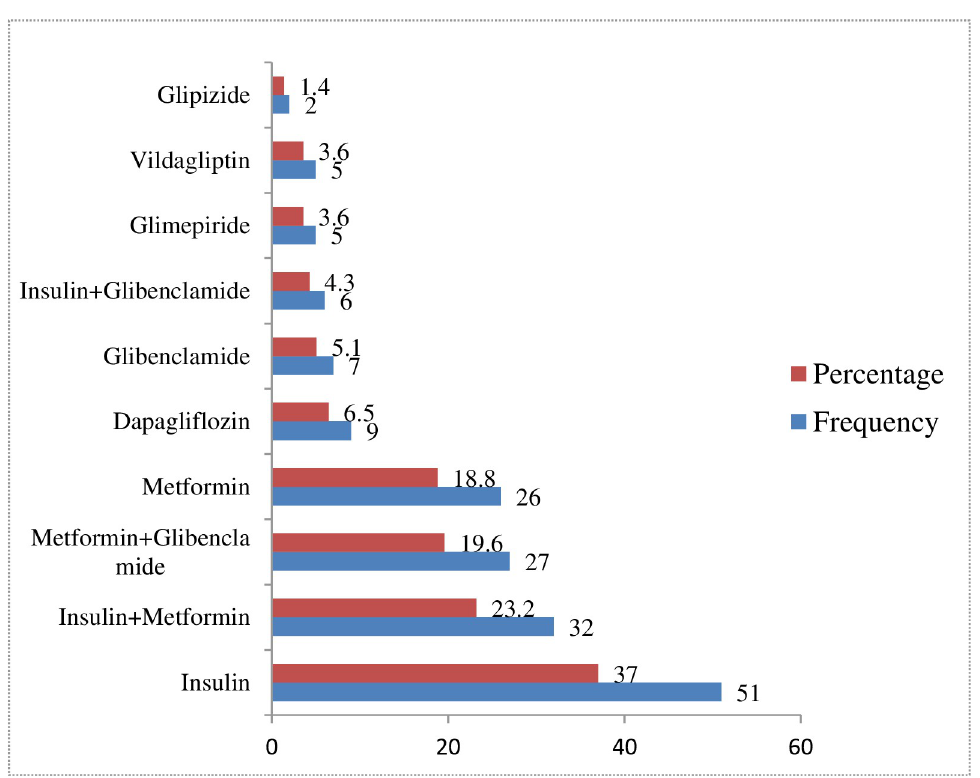
Fig 2. Anti-diabetics used among T2DM patients at medical and surgical wards of MRRH, Mbarara,